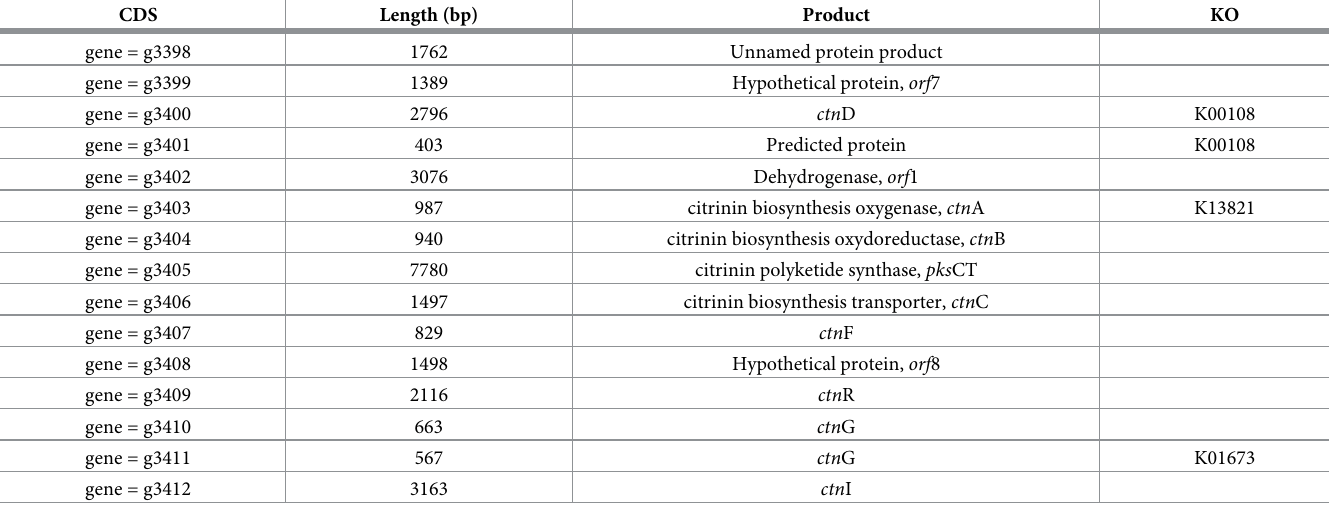
Table 3. Functional prediction of genes detected in the citrinin BGC of M . purpureus